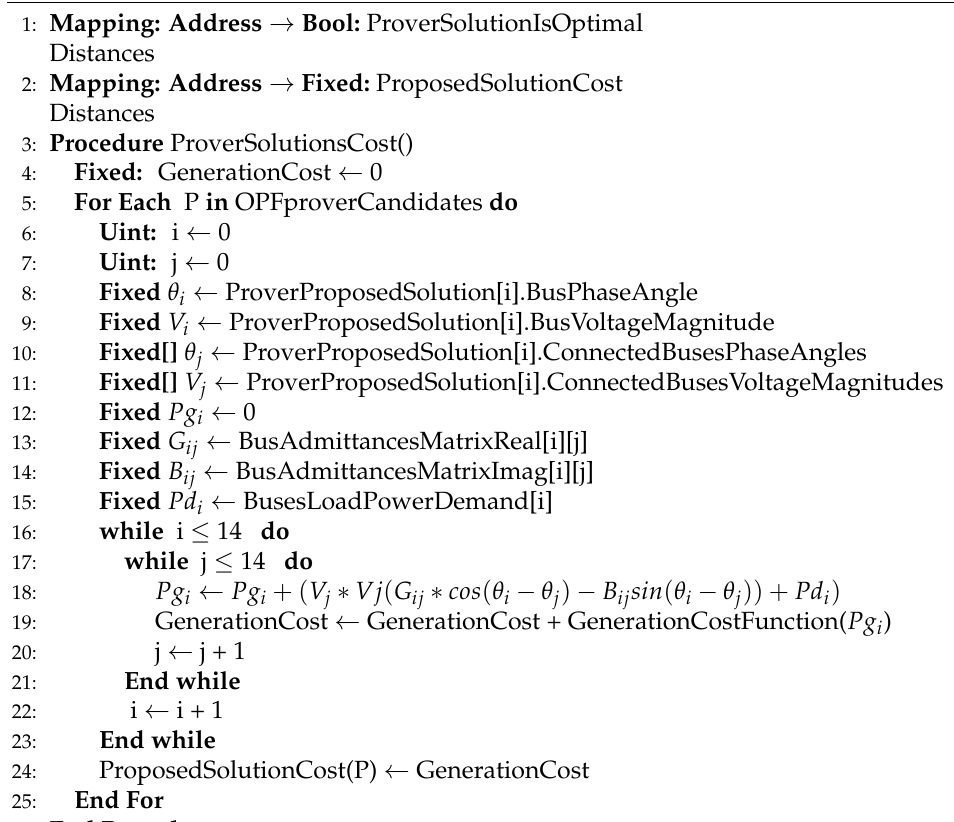
Algorithm 9 OPF Smart Contract: